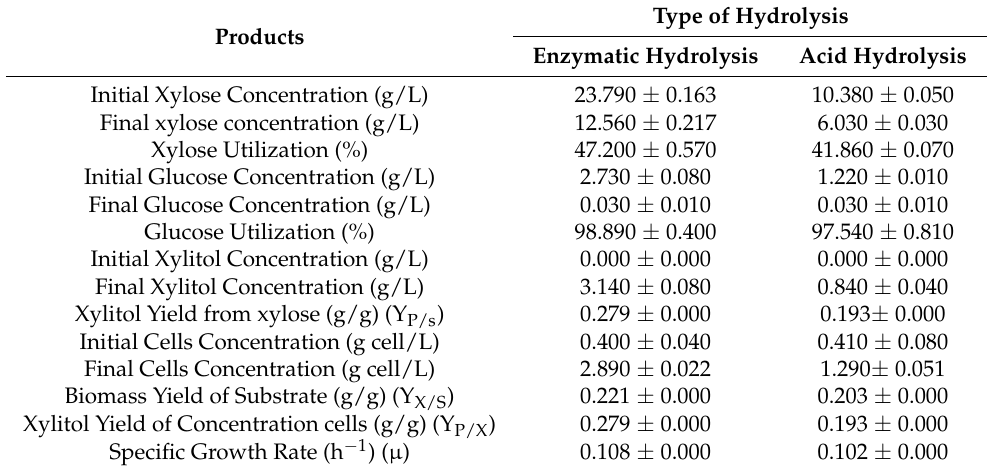
Table 3. Fermentation products of enzyme hydrolysate and acid hydrolysate by D. hansenii